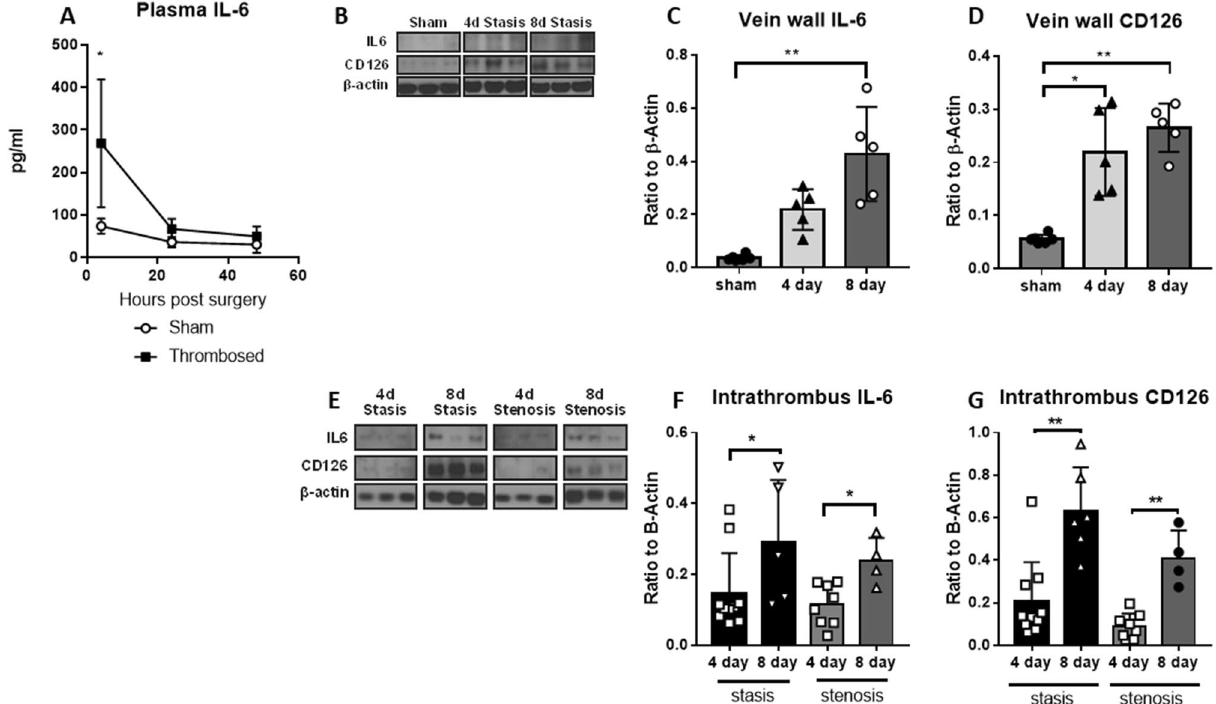
Figure 1. IL-6 and IL-6 receptors are elevated in murine and human post thrombotic tissue. A . Plasma IL-6 levels drawn following sham surgery with retroperitoneal dissection or surgery with IVC ligation in WT mice resulting in stasis thrombosis (n = 5 per group). Following sham surgery or stasis thrombosis, vein wall lysate protein levels ( B ) of IL-6 ( C ) and CD126 ( D ) measured by Western blotting (n = 4–10/group). Gel blots cropped from different parts of the gel are presented, with white line separation. Protein levels of intrathrombus ( E ) IL-6 ( F ) and CD126 receptor ( G ) were measured at 4 and 8 days in partially occlusive (stenosis) and completely occlusive thrombi (stasis). All data presented as mean ± standard deviation. Normally distributed data was compared utilizing unpaired student’s test with Welch’s correction and non-normally distributed data compared with Mann–Whitney U test. *p < 0.05, **p <